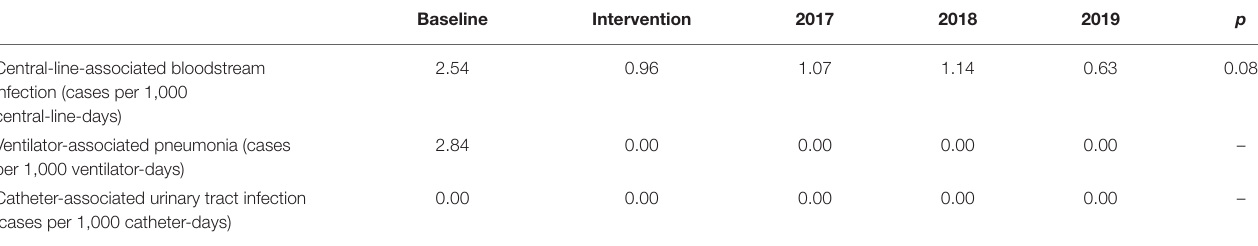
TABLE 6 | Incidence of ICU-acquired catheter-related infections caused by CRKP (cases per 1,000 catheter-days) from different infection sites in the study period. Baseline Intervention Central-line-associated bloodstream infection (cases per 1,000